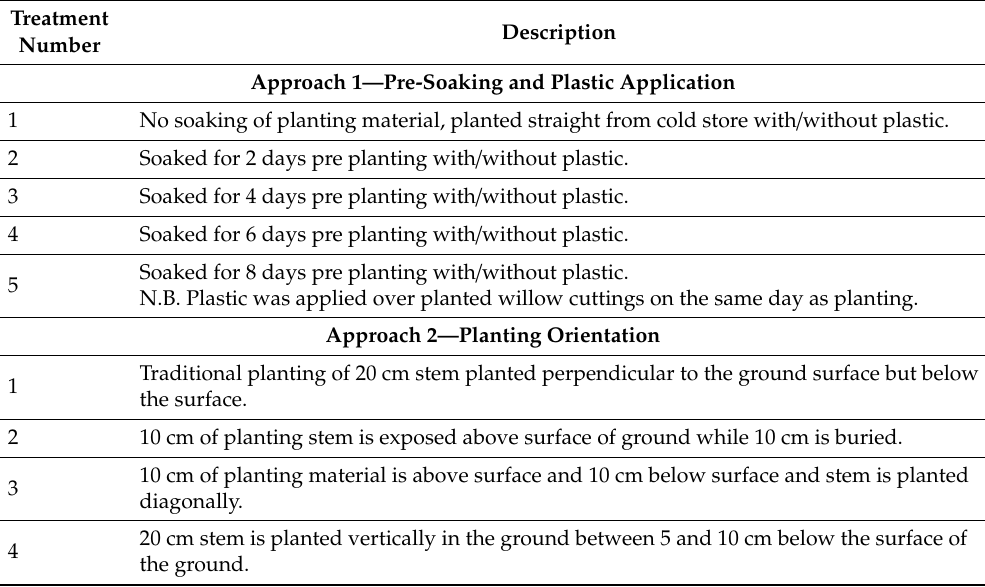
Table 1. Description of the treatments in the three